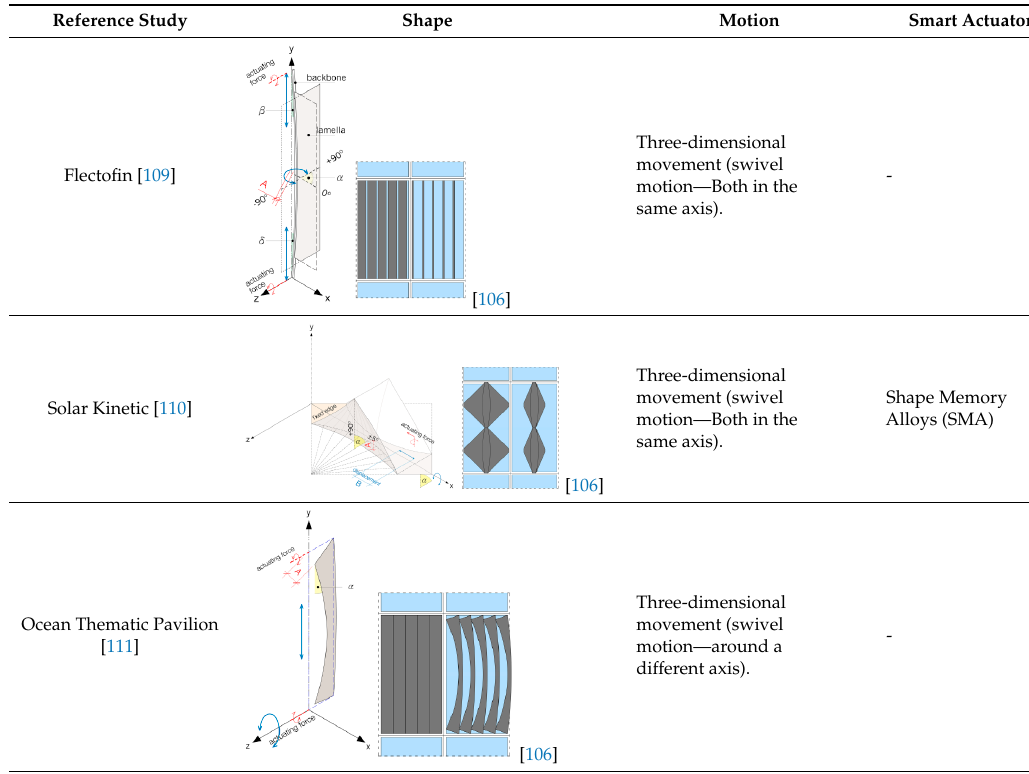
Table 5. Different types of folding shading systems.